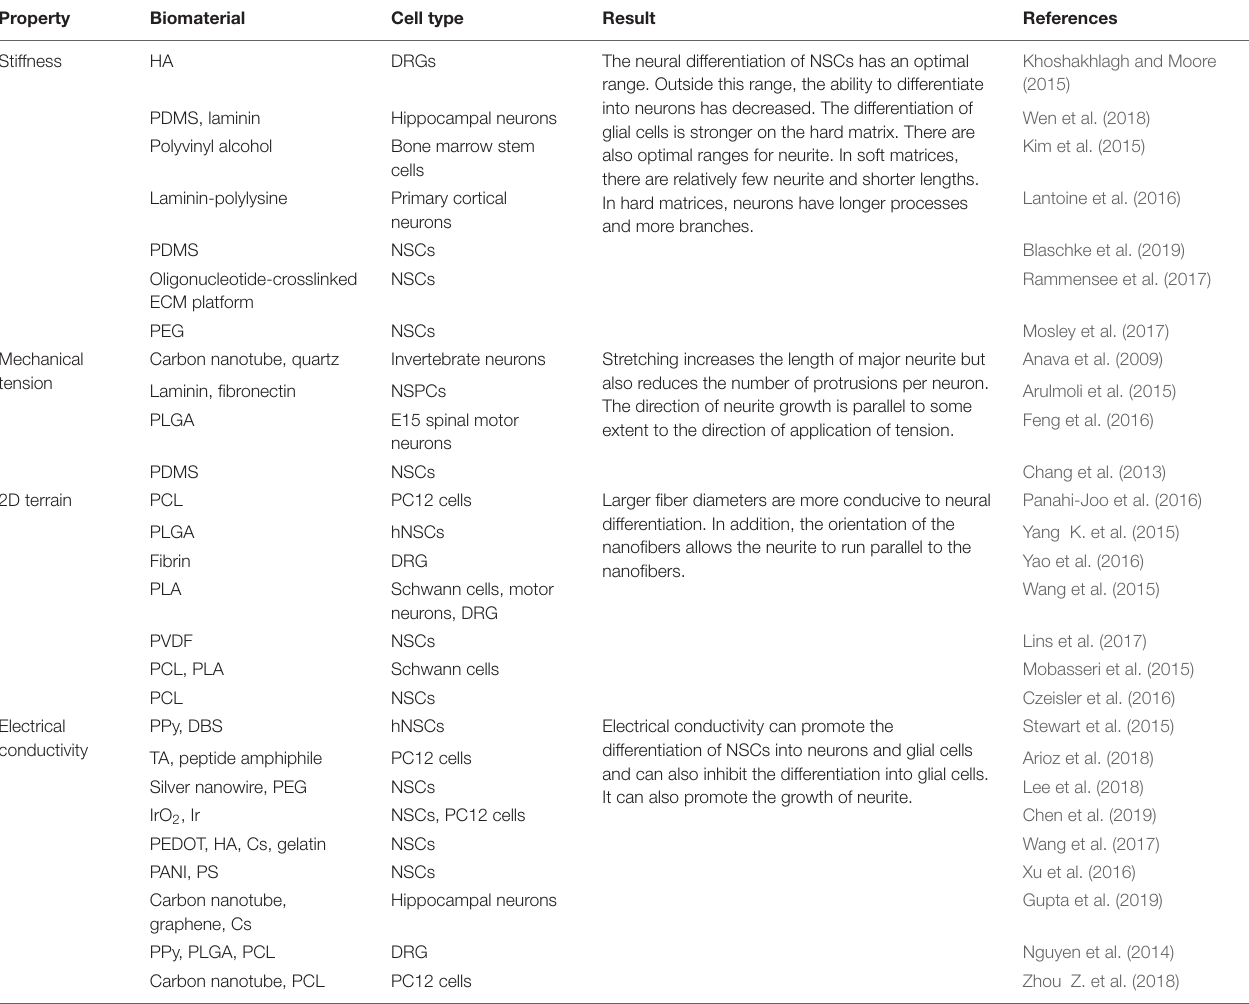
TABLE 1 | Behavior regulation of neural cells by physical cures of biomaterial